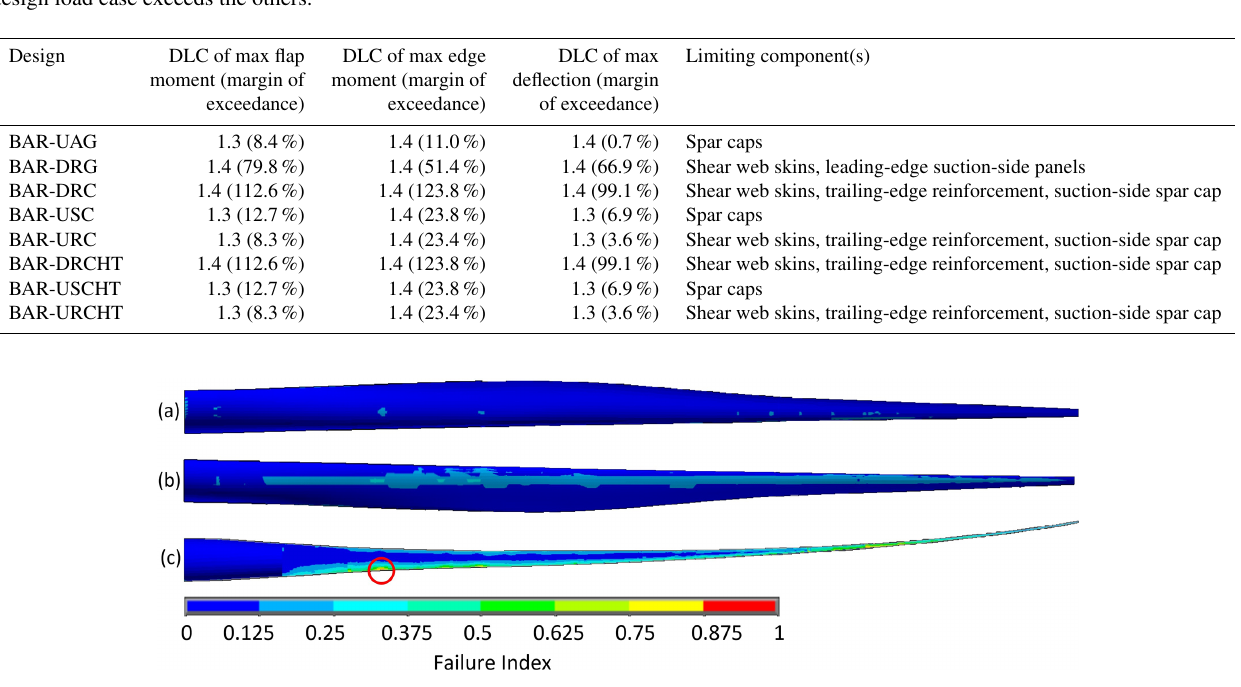
Table 7. Driving design load cases and limiting components for optimized blade designs. Included is the margin by which the indicated design load case exceeds the others.